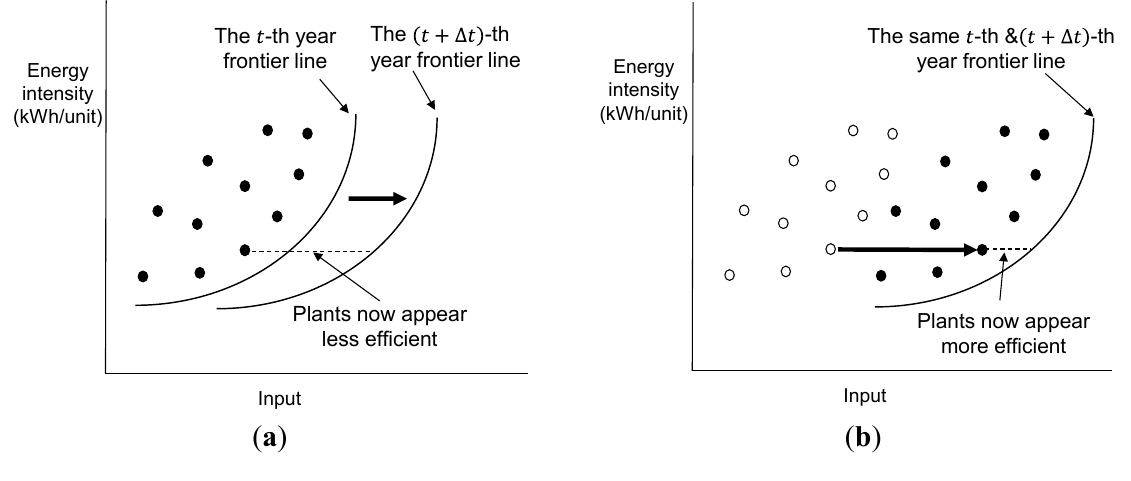
Figure 5. Two main sources affecting changes in the plant energy efficiency over time. ( a ) Shifts in frontier line independent of a set of observations; ( b ) Movement of a set of observations closer to the frontier